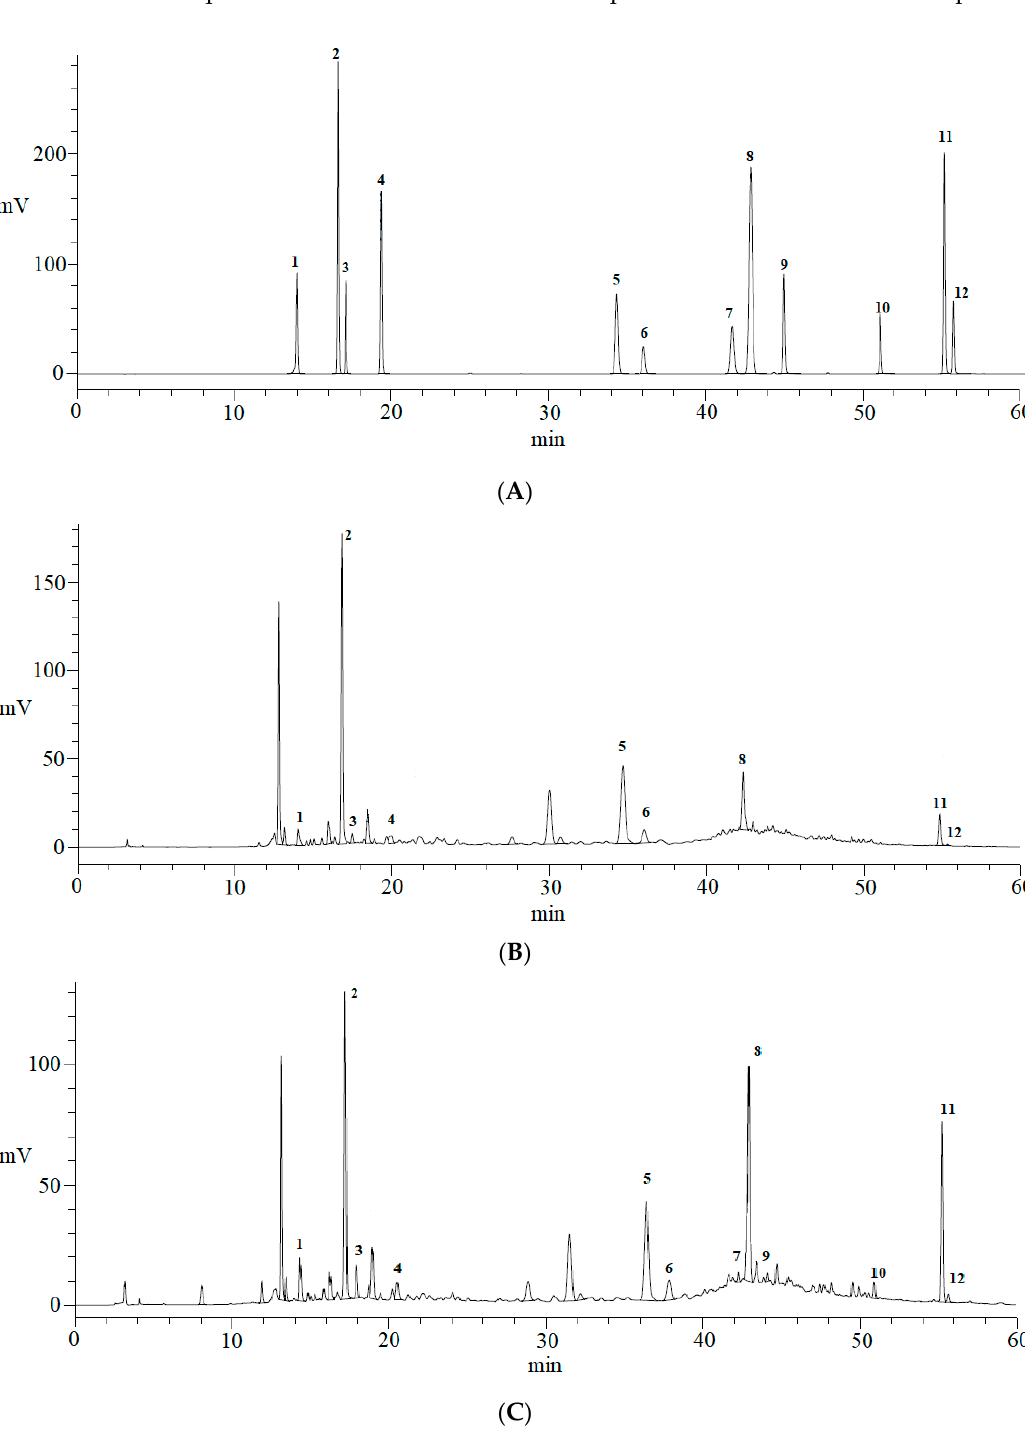
Figure 2. The HPLC fingerprints of the mixed standard substance ( A ), CS ( B ), and PCS samples ( C